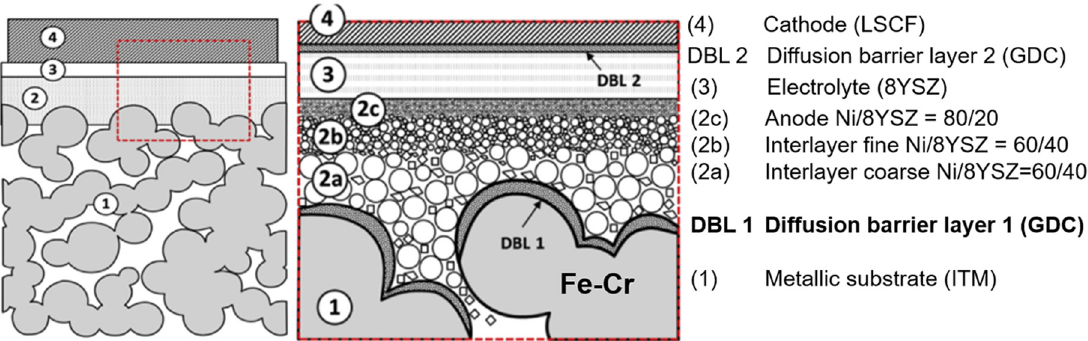
Figure 6. Schematic of the diffusion barrier layer method in metal-supported cells, reproduced with permission from Ref. [57].